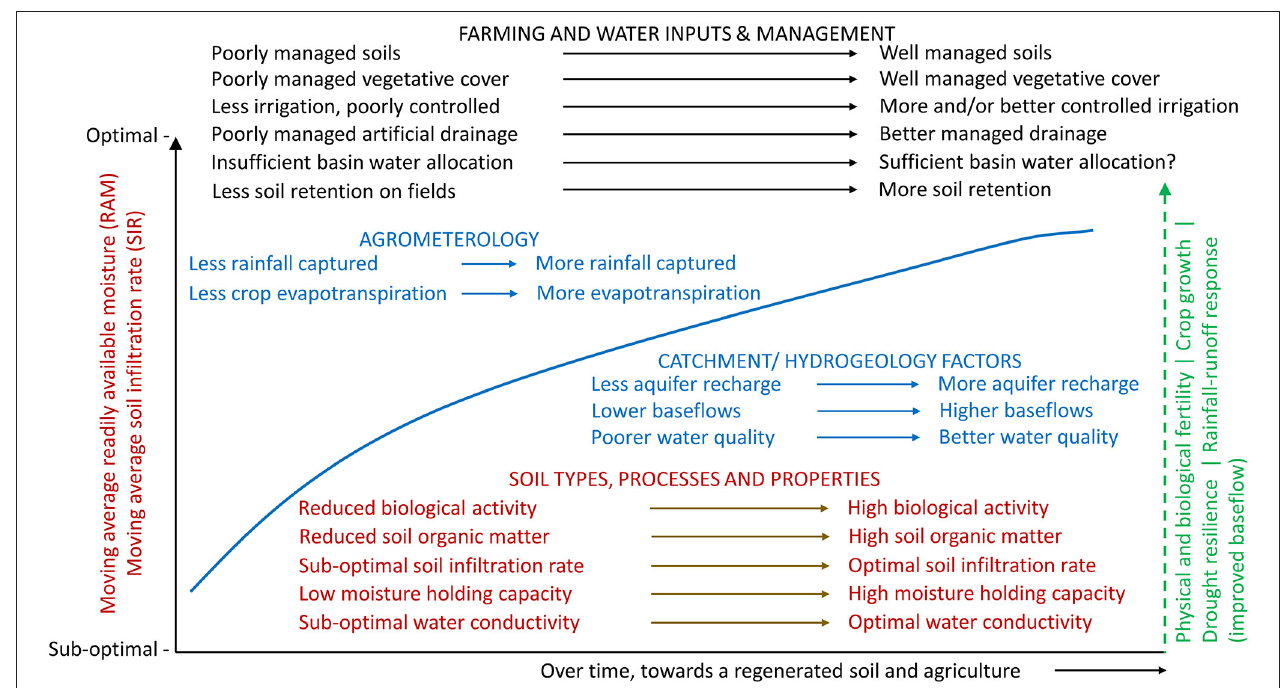
FIGURE 5 | Regenerating RAM and SIR upwards over time for a given soil type to build RA promises.